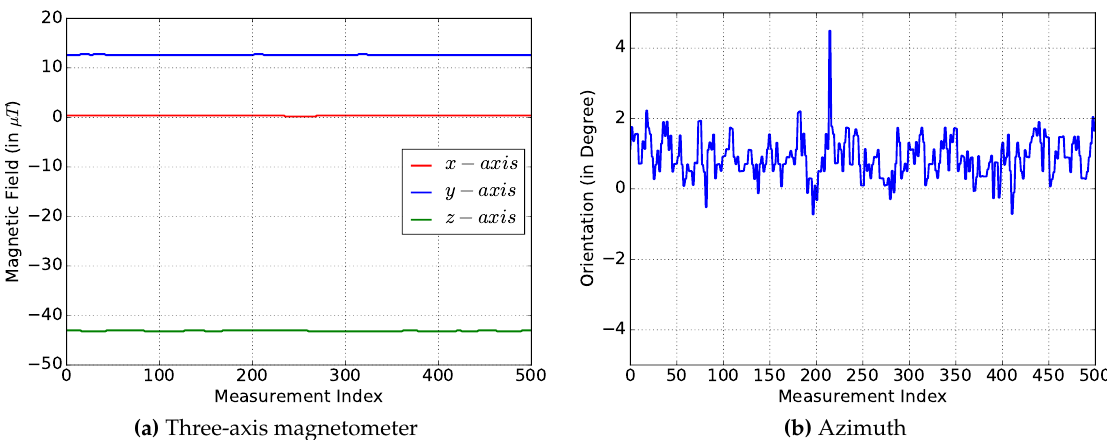
Figure 7. Acceleration